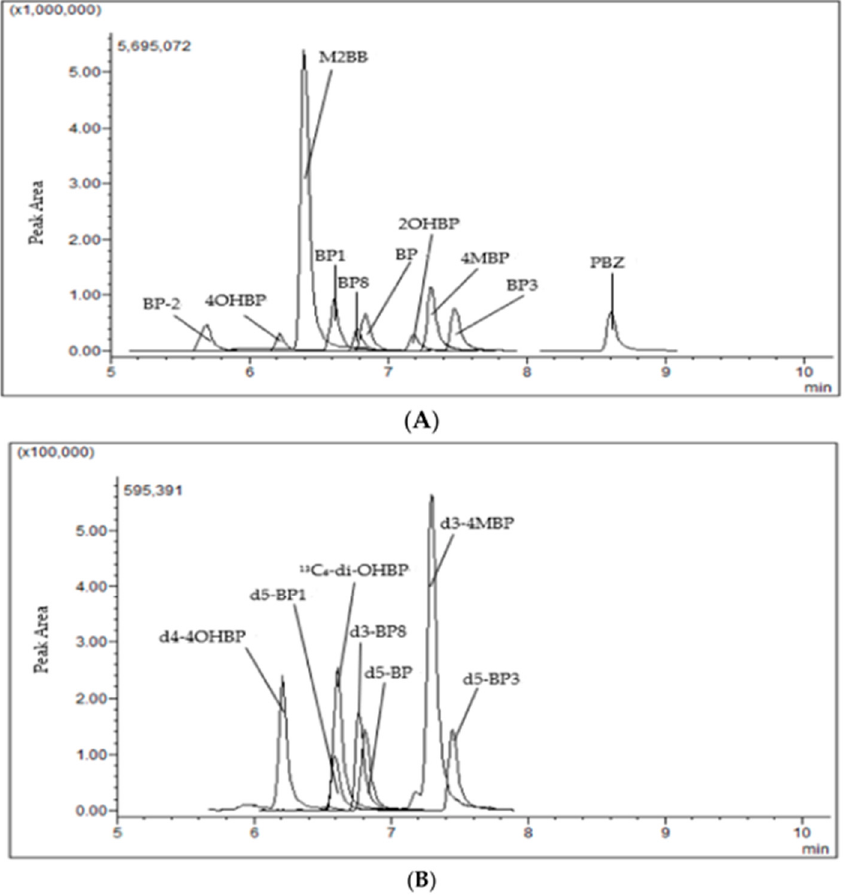
Figure 3. The representative chromatogram of a rice cereal sample spiked with 20 ng/g of the BP and BP analog standards ( A ) and 8 ng/g of the ILIS ( B ).